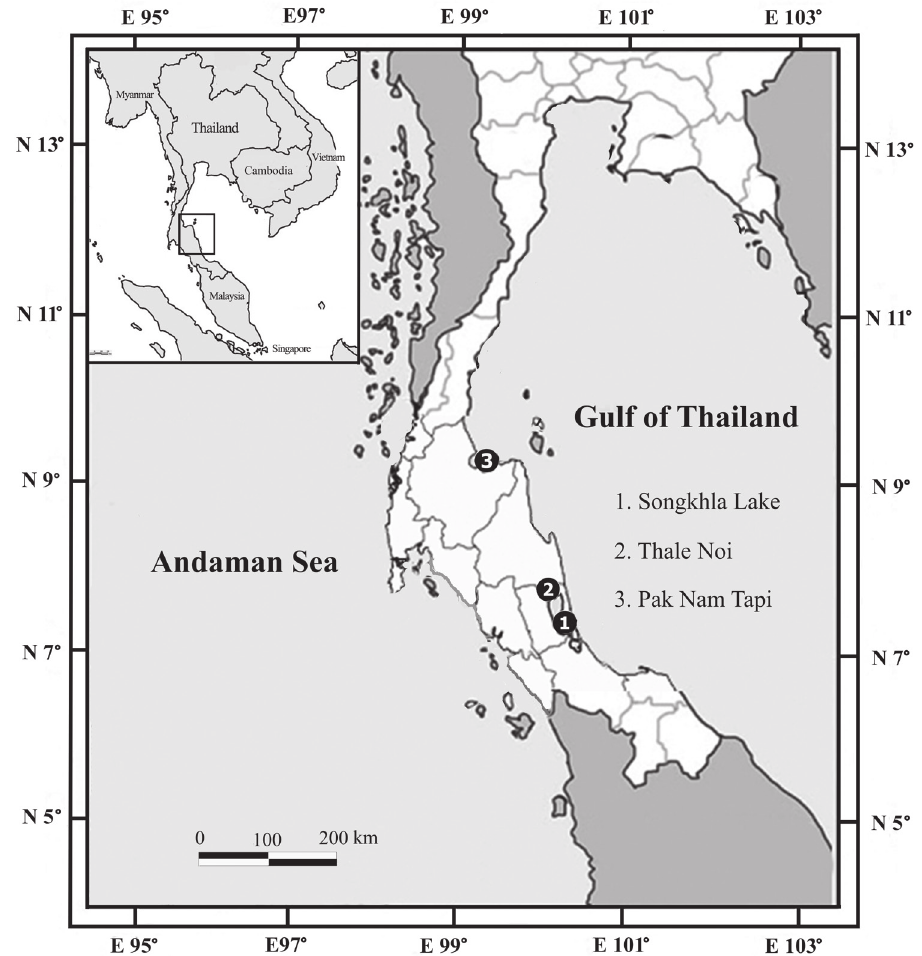
Figure 1. Map of sampling